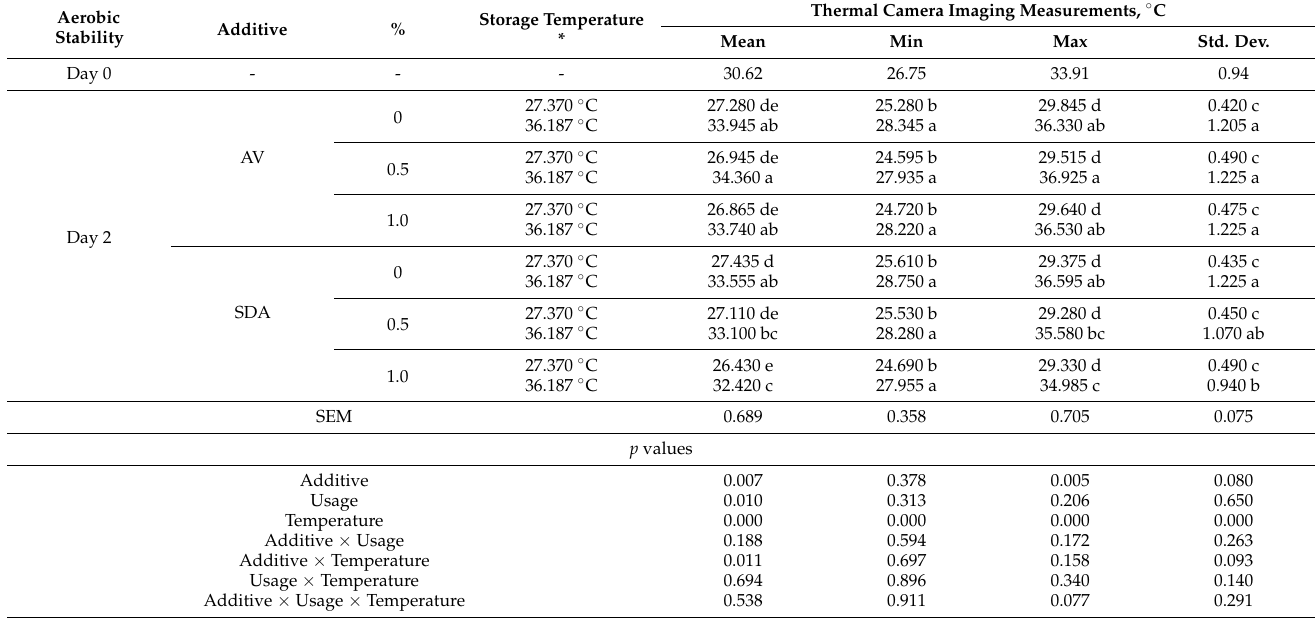
Table 6. Thermal camera imaging results of aerobic stability on day 2 (Ambient temperature = 22 ◦ C).